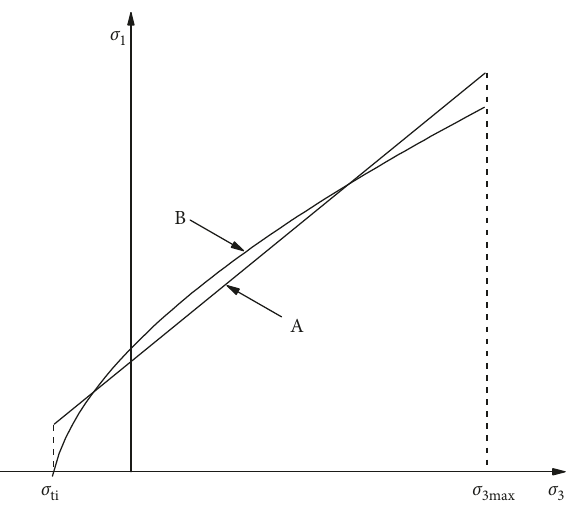
Figure 1: Hoek–Brown criteria and the equivalent Mohr– Coulomb